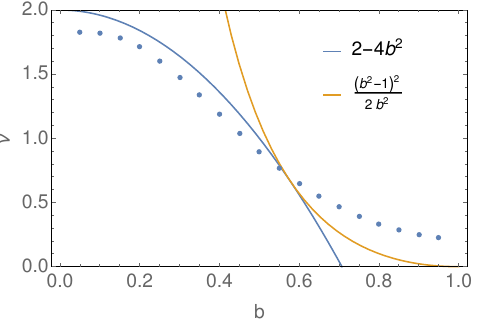
Figure 20. Power law exponents as a function of b as determined from TSM extrapolation (blue dots) vs those predicted by eq. (7.14) (solid orange curve) and the exponent of the leading naïve RG correction eq.